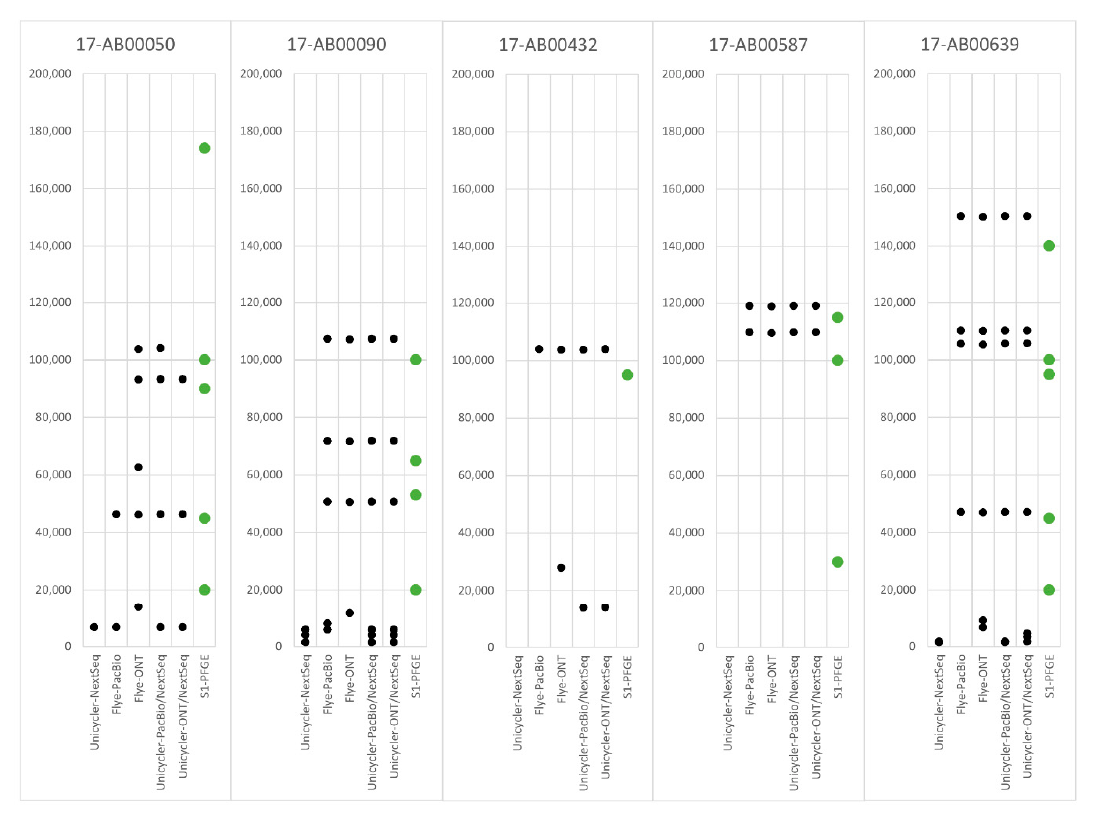
Figure 1. Distribution of plasmid size, detected with different sequencing and assembly approaches. A black dot represents a determined closed plasmid at the respective size for the given method. A green dot represents the size of the plasmid, detected in the laboratory with S1-PFGE.